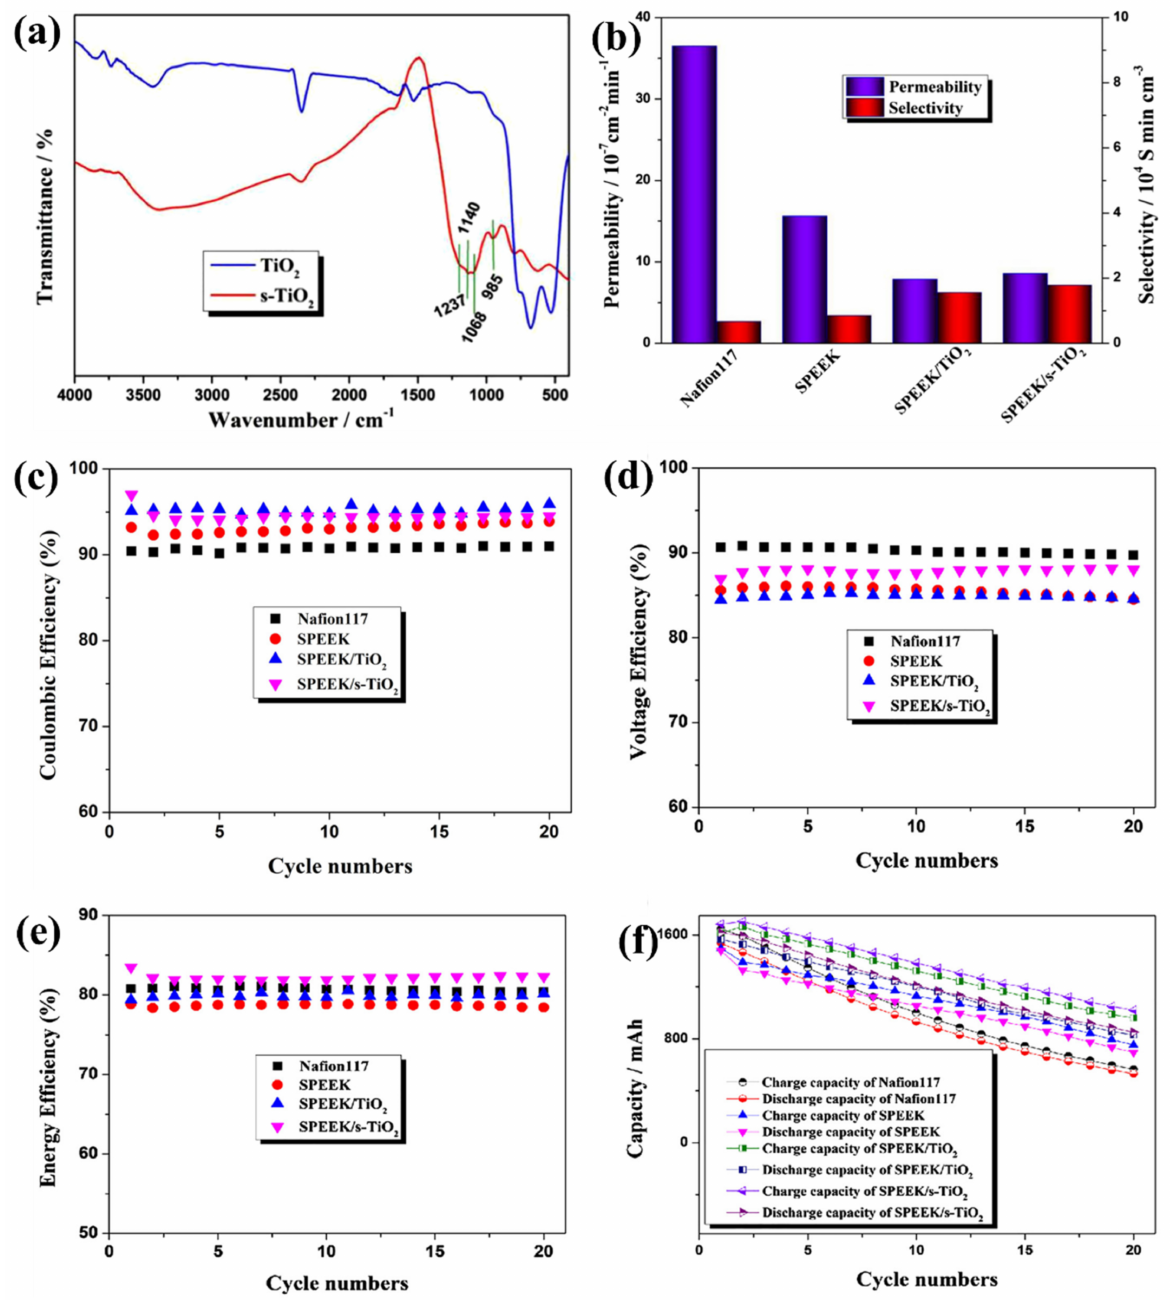
Figure 6. ( a ) FT-IR spectra of TiO 2 before and after sulphonation. ( b ) Vanadium ion permeability and selectivity, ( c ) coulombic efficiency, ( d ) voltage efficiency, ( e ) energy efficiency, and ( f ) cycle stability of membranes (Nafion117, sPEEK, sPEEK-TiO 2 , and sPEEK-s-TiO 2 ). Reprinted with permission